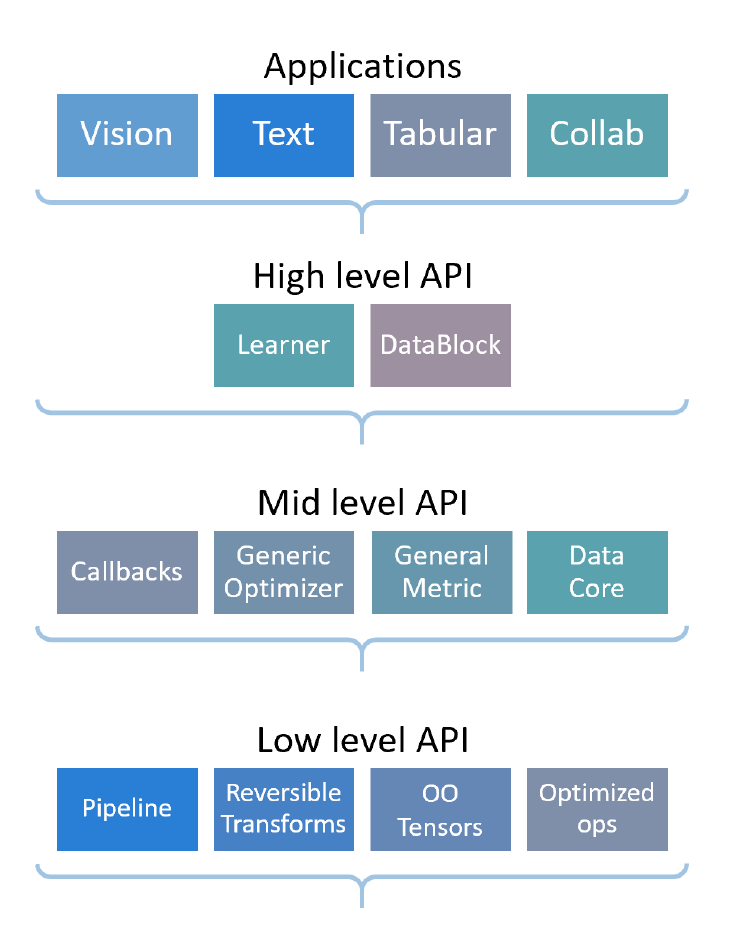
Figure 1. The layered API from